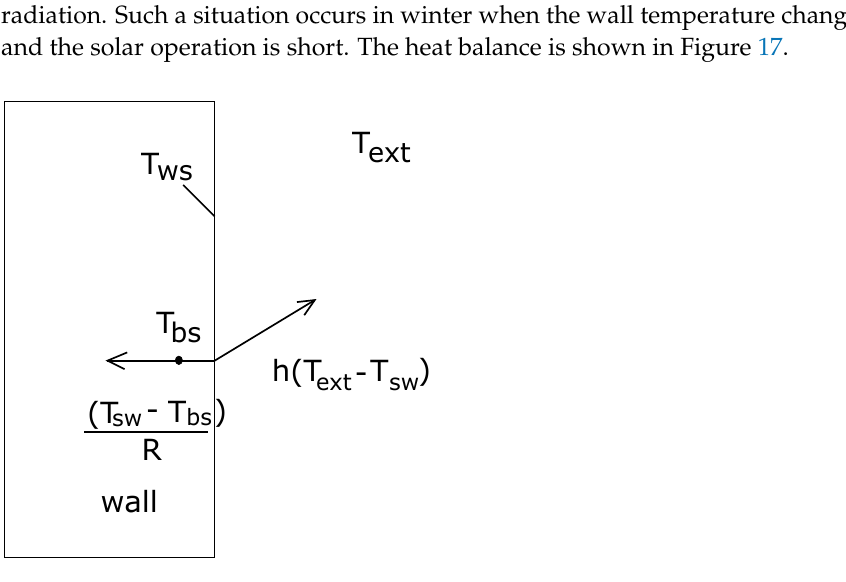
and the Nusselt number